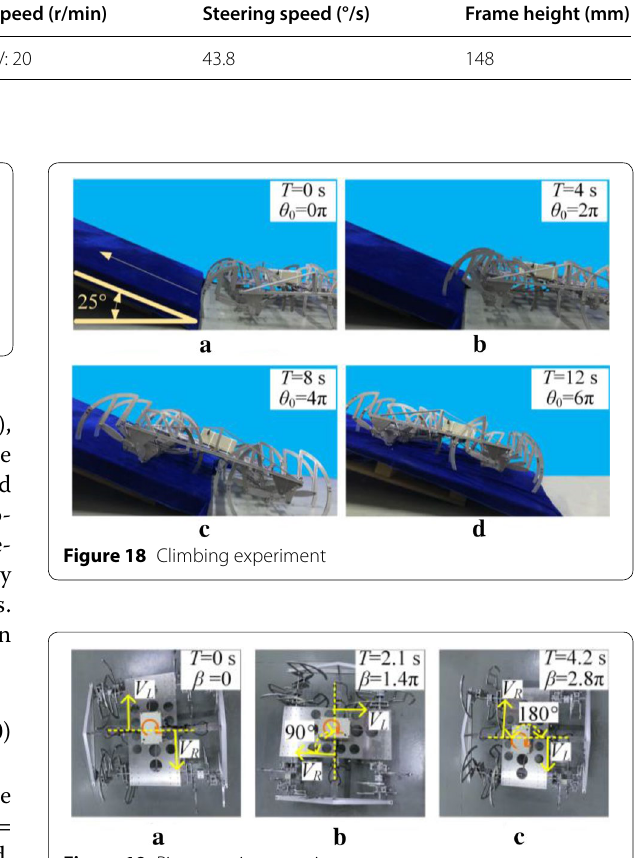
Figure 19 Pivot steering